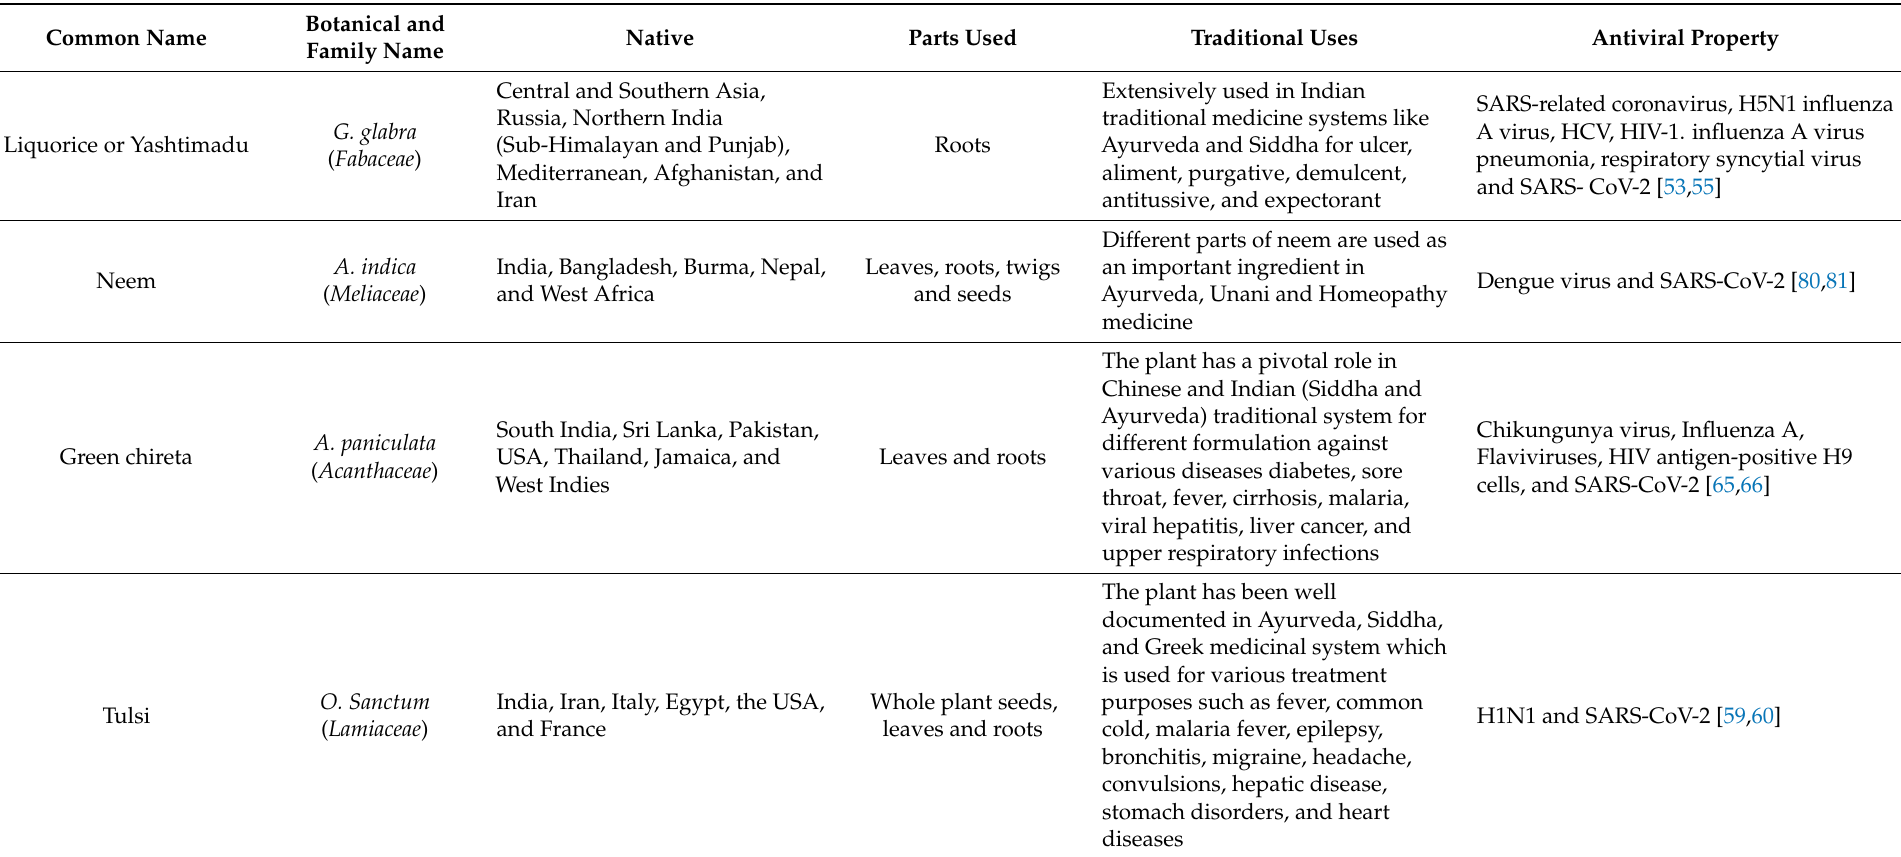
Table 1. Indian plants with antiviral